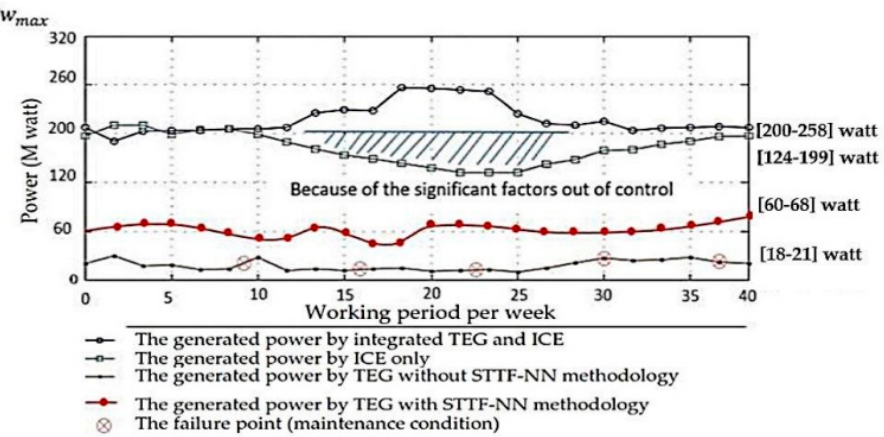
Figure 23. The generated electrical power for the diesel and thermoelectric generators through the digital twin simulator through 6241 working hours.